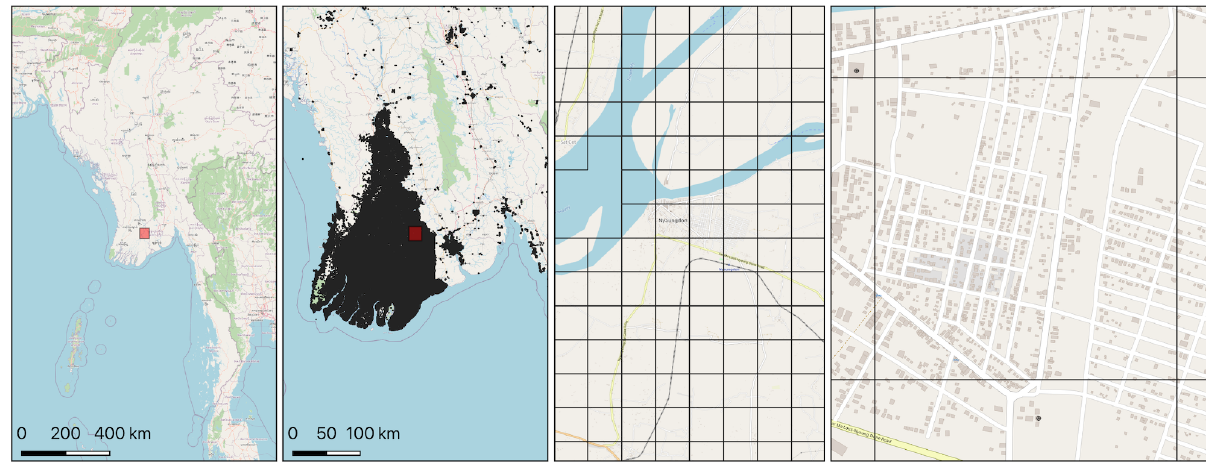
Figure 2. Tiles in the database used for the analysis, showing an example for the area of Nyaungdon, a town in the Ayeyarwady Region of southwest Myanmar. The tiles are generated only for areas with at least one building. (c) OpenStreetMap contributors.